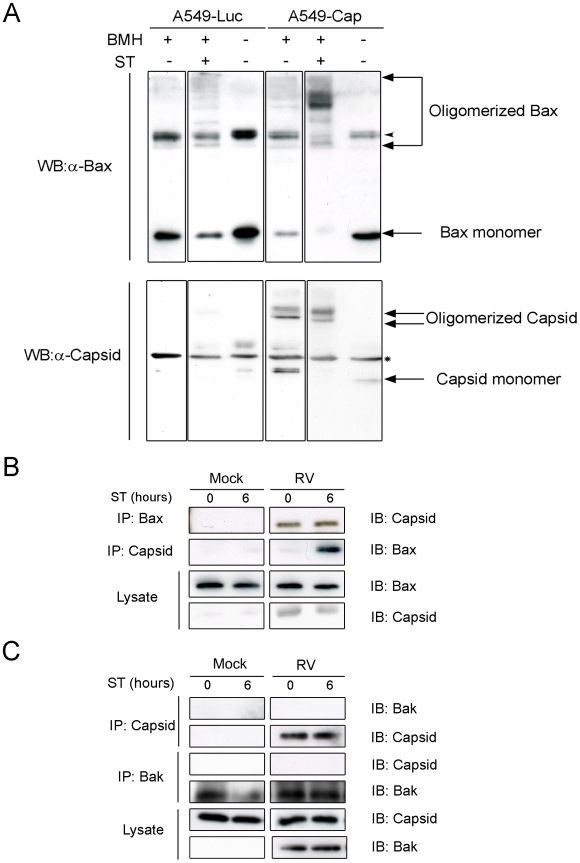
Capsid protein forms complexes with Bax.A. Stably transduced A549 cells expressing luciferase (Luc) or capsid protein (Cap) were treated with staurosporine (ST) for 6 hours. After ST treatment, crude mitochondria were isolated and then crosslinked with BMH prior to analyses by immunblotting with antibodies to capsid and Bax. The arrowhead in the upper panels denotes an SDS-resistant Bax dimer that is present in all samples. The asterisk in the lower panels denotes a non-specific protein that cross-reacts with the capsid antibody. A549 cells were infected with RV and at 42 hours, were treated with ST for 0 to 6 hours. Cell lysates were subjected to immunoprecipitation (IP) with antibodies to capsid, Bax (B) or Bak (C) followed by SDS-PAGE and immunoblotting (IB).